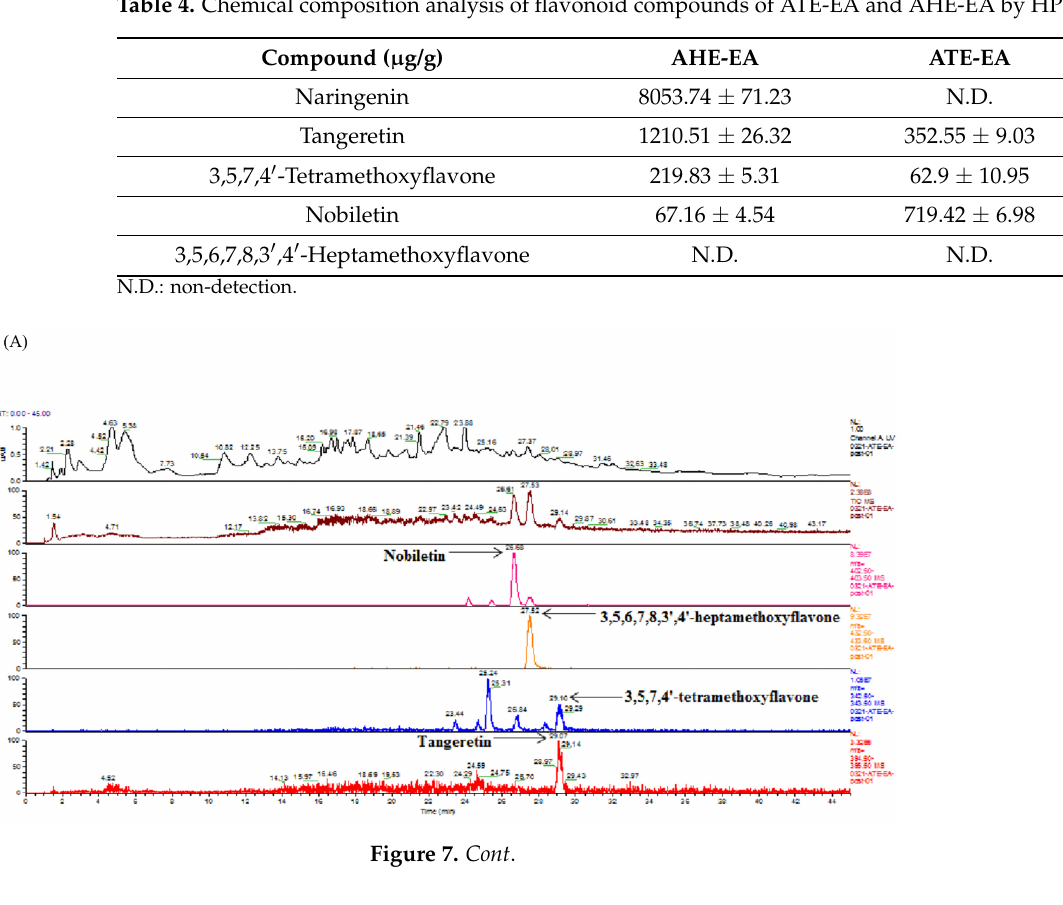
The data are presented as mean ± SD (n = 8) and analyzed with one-way ANOVA with Duncan’s multiple comparison test. Different letters indicate significant differences among groups at the level of p < 0.05.